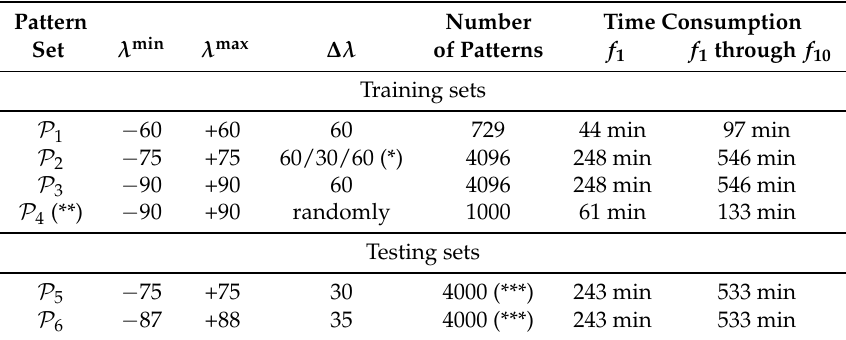
Table 9. Pattern sets (three-segment